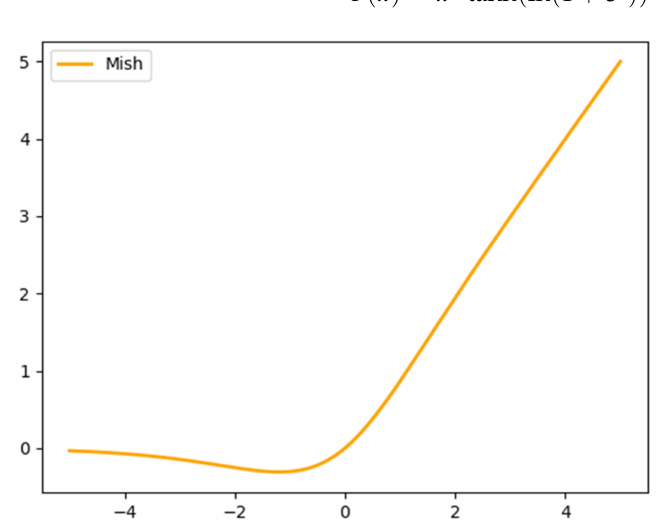
Figure 2. The function graph of